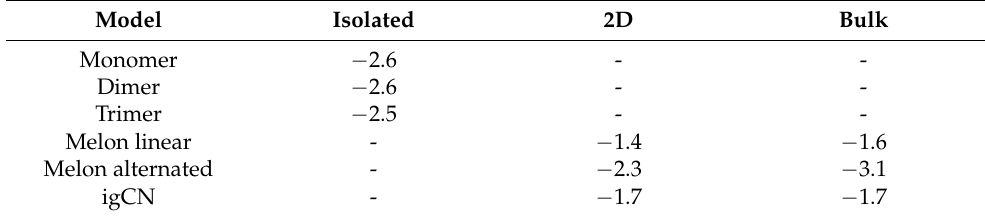
Table 1. List of chemical shifts (in eV) between XPS spectra calculated for different models of gCN polymers and melem aggregates with respect to a common reference, an isolated N 2 molecule inserted into the simulation cell. Model Isolated 2D Bulk Monomer − 2.6 - - Dimer − 2.6 - - Trimer − 2.5 - - Melon linear - − 1.4 − 1.6 Melon alternated - − 3.1 igCN - −